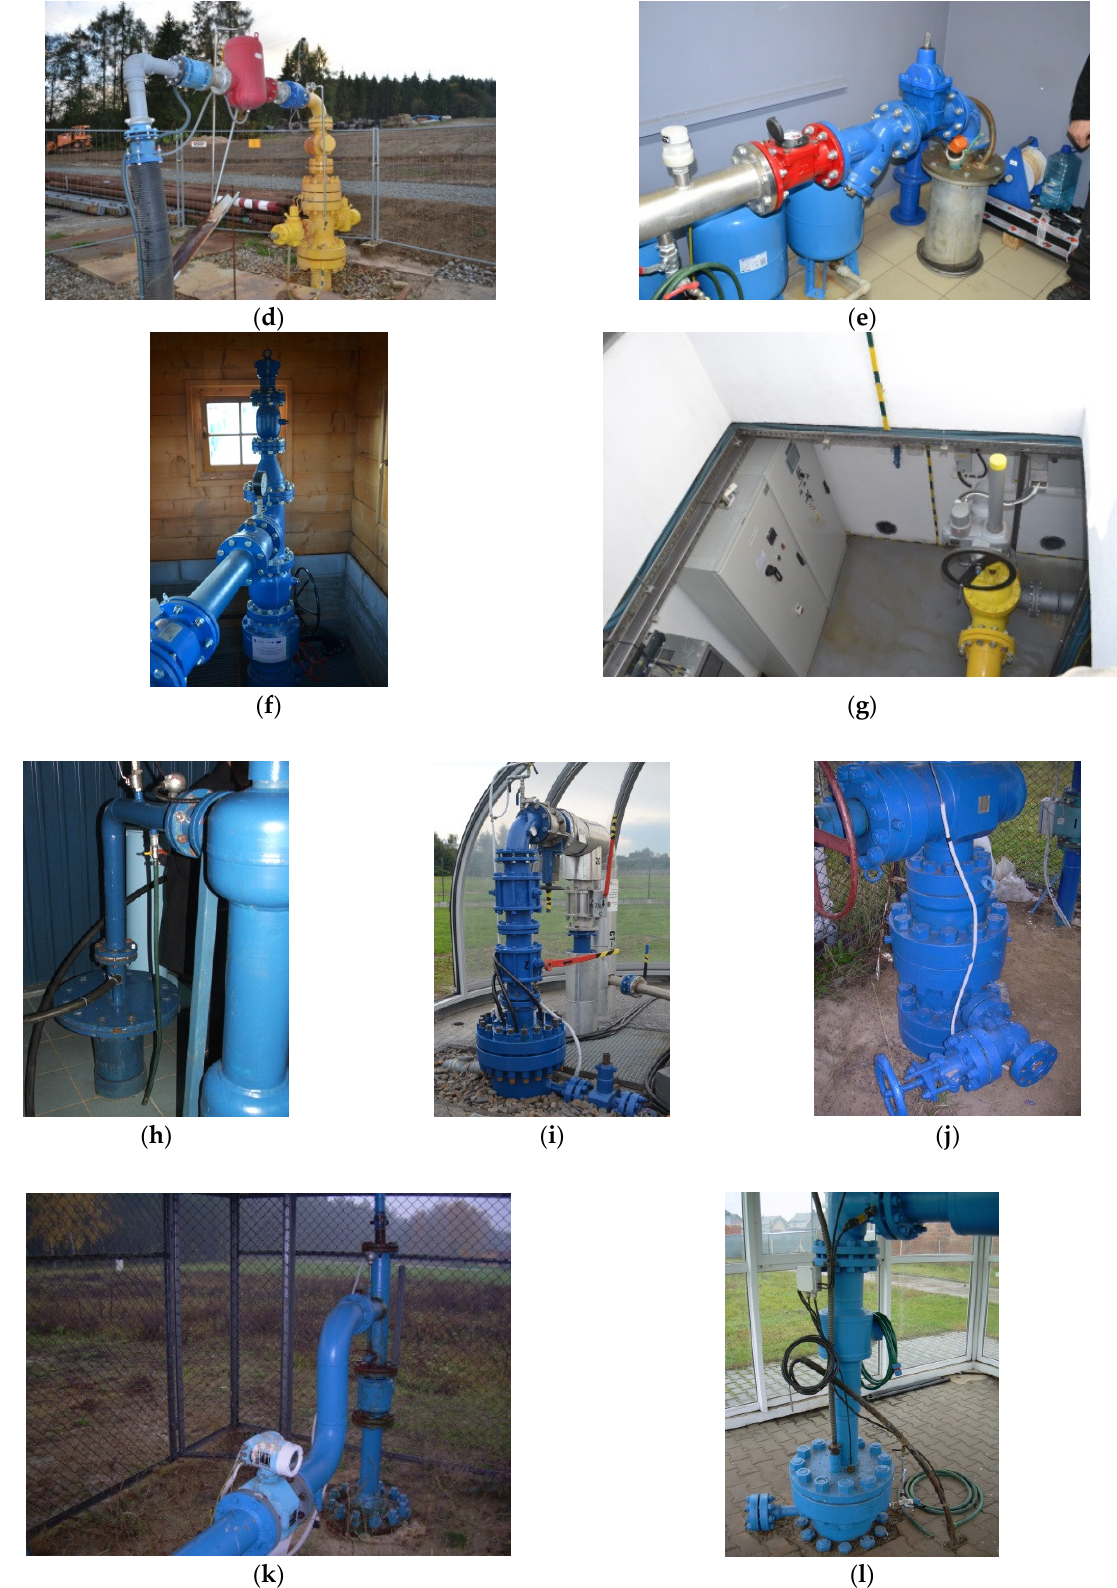
Figure 2. Well head of borehole: ( a ) Bańska IG-1, ( b ) Bańska PGP-1, ( c ) Bańska PGP-3, ( d ) BiałkaTatrzańska GT-1, ( e ) Bukowina Tatrzańska PIG/PNiG-1, ( f ) Chochołów PIG-1, ( g ) Kleszczów GT-1, ( h ) Mszczonów IG-1, ( i ) Poddębice GT-2, ( j ) Uniejów PIG/AGH-1, ( k ) Uniejów IG-1, ( l ) Uniejów PIG/AGH-2.